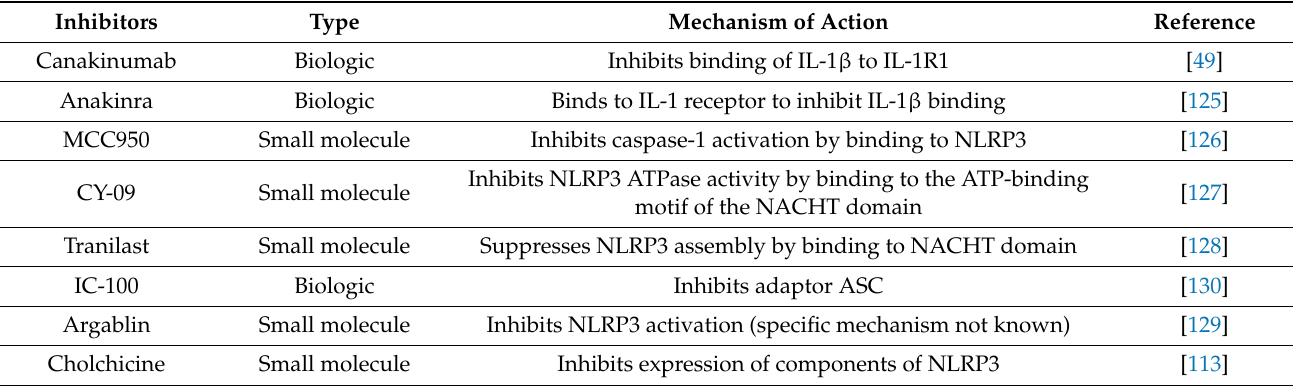
Table 2. Novel IL-1 β and NLRP3